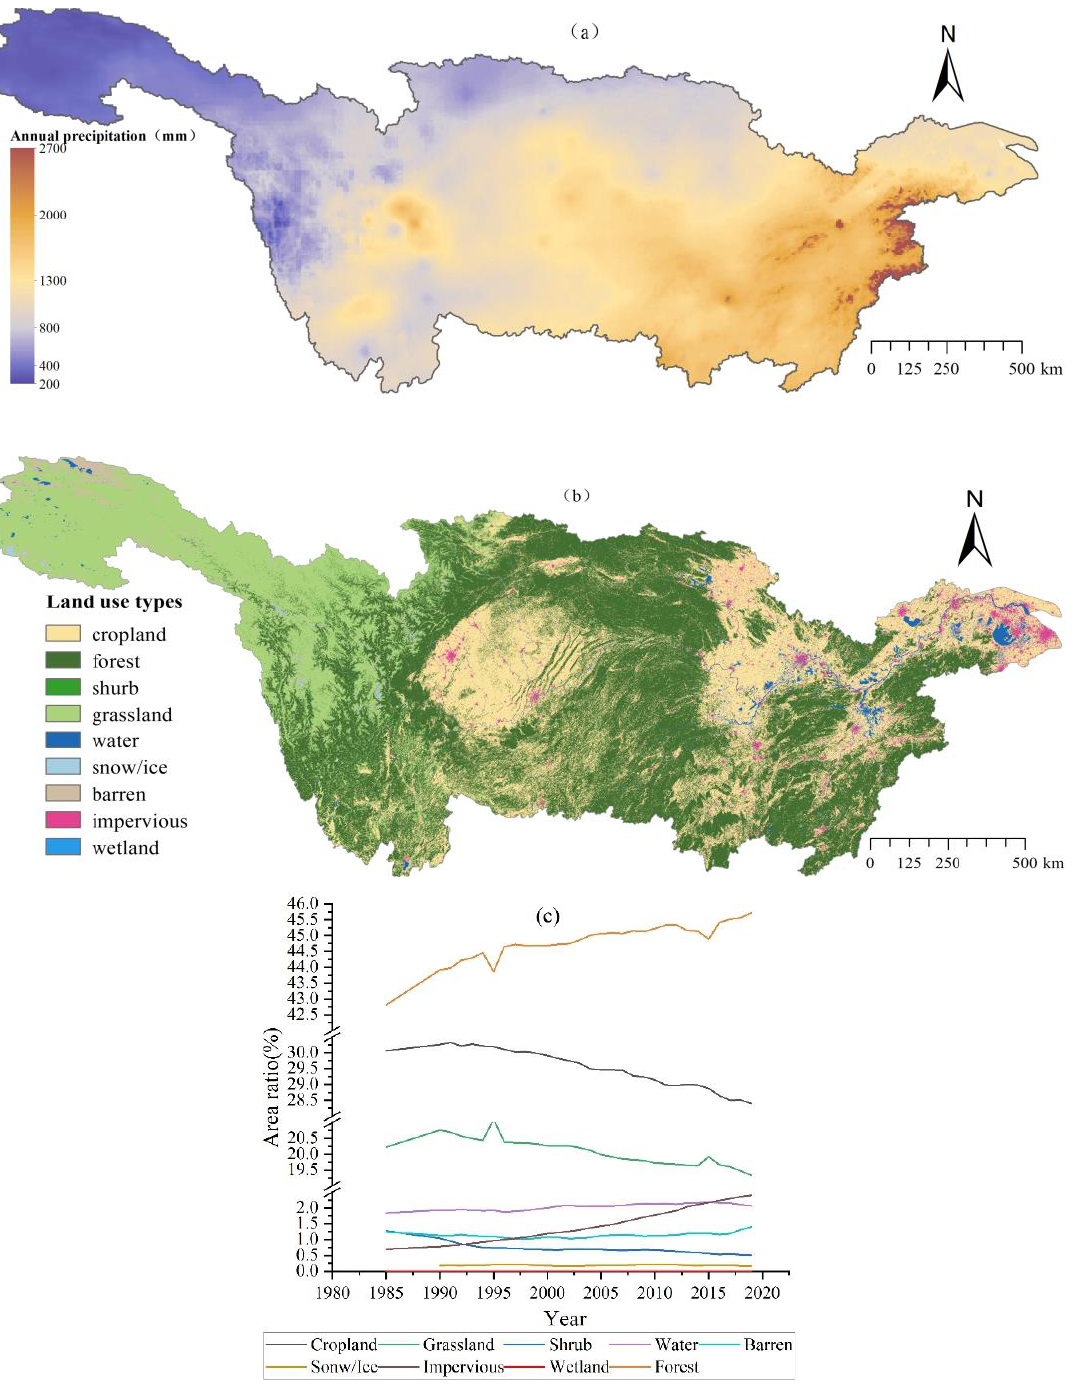
Figure 4. ( a ) The average annual precipitation of the Yangtze River Basin from 1986 to 2021; ( b ) Distribution of land use types in the Yangtze River Basin in 2019; ( c ) Area Changes of land use types in the Yangtze River Basin from 1985 to